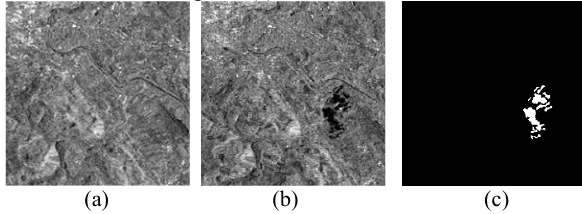
Figure 1. The flowchart of the proposed method In the experiment, a 3 × 3 window is used to instead the homogenous region and the difference image has been normalized to 0-255 to calculate convenient. Before thresholds selection, a 3 × 3 Lee filter has been done on the difference image which is shown in Figure3 (a).